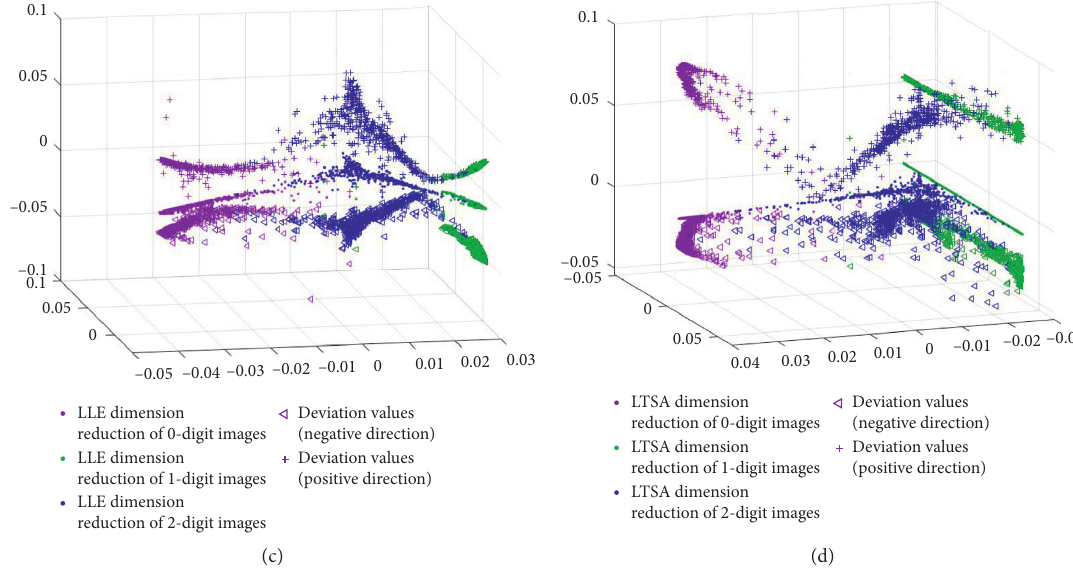
Figure 18: Manifold dimension reduction results for “0,” “1,” and “2” and results of deviation